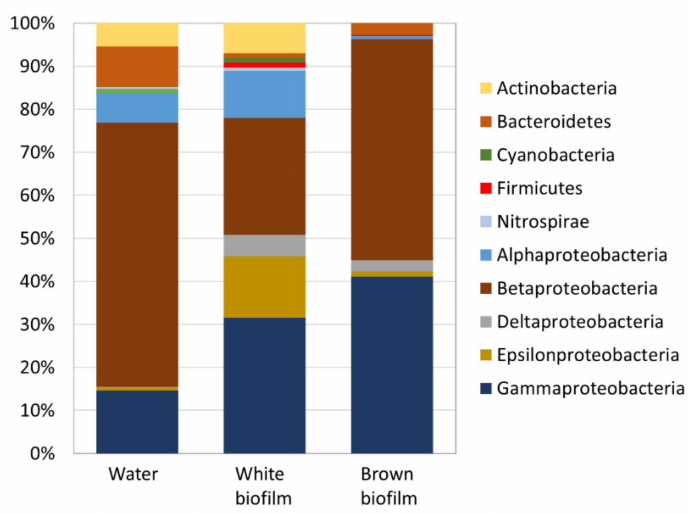
Figure 6. Relative abundance of bacterial phyla in water and biofilm samples from the Smrdljivec spring. The phylum of Proteobacteria is subdivided into class levels (Alpha-, Beta-, Delta-, Epsilon-,